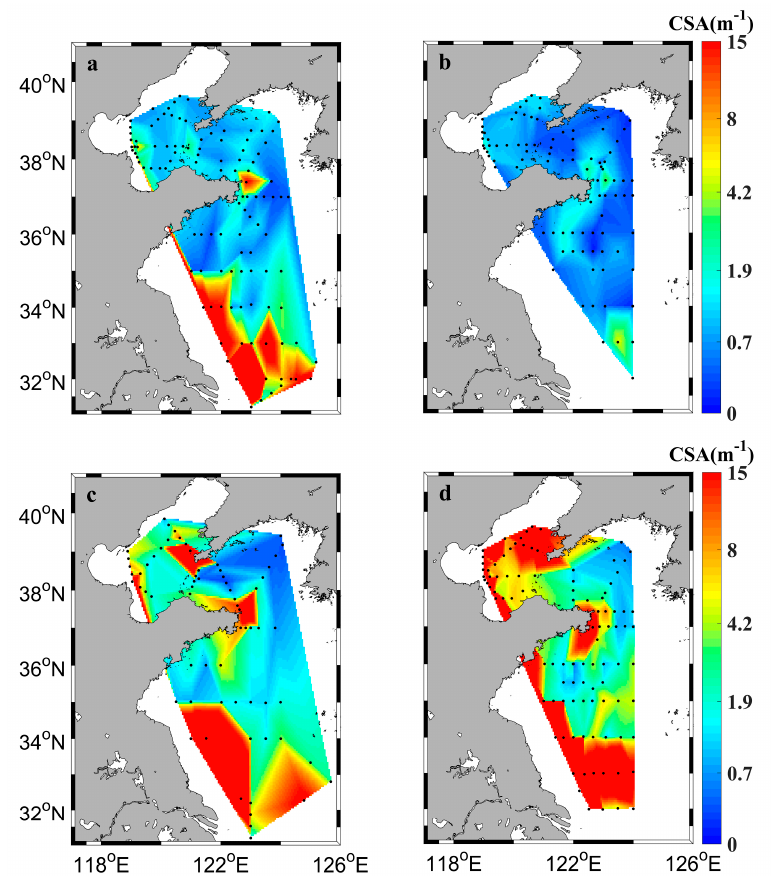
Figure 6. CSA distribution in the bottom layer in ( a ) spring, ( b ) summer, ( c ) autumn, and ( d ) winter. The interpolation method was the same as Figure 4.